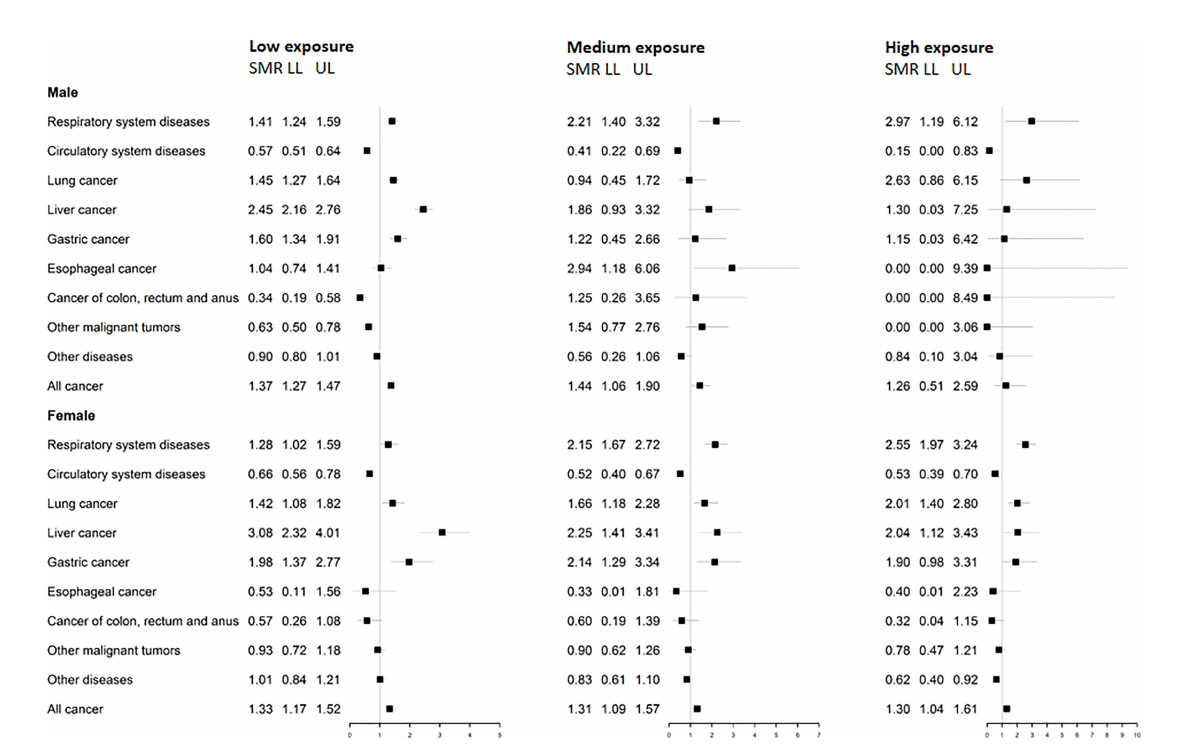
FIGURE 4 SPMRs and 95% CIs compared with mortality data of Eastern China by gender and district of different asbestos exposure level. SPMRs and 95% CIs were strati fi ed by asbestos exposure levels; LL , lower limit of the con fi dence interval; UL , upper limit of the con fi dence